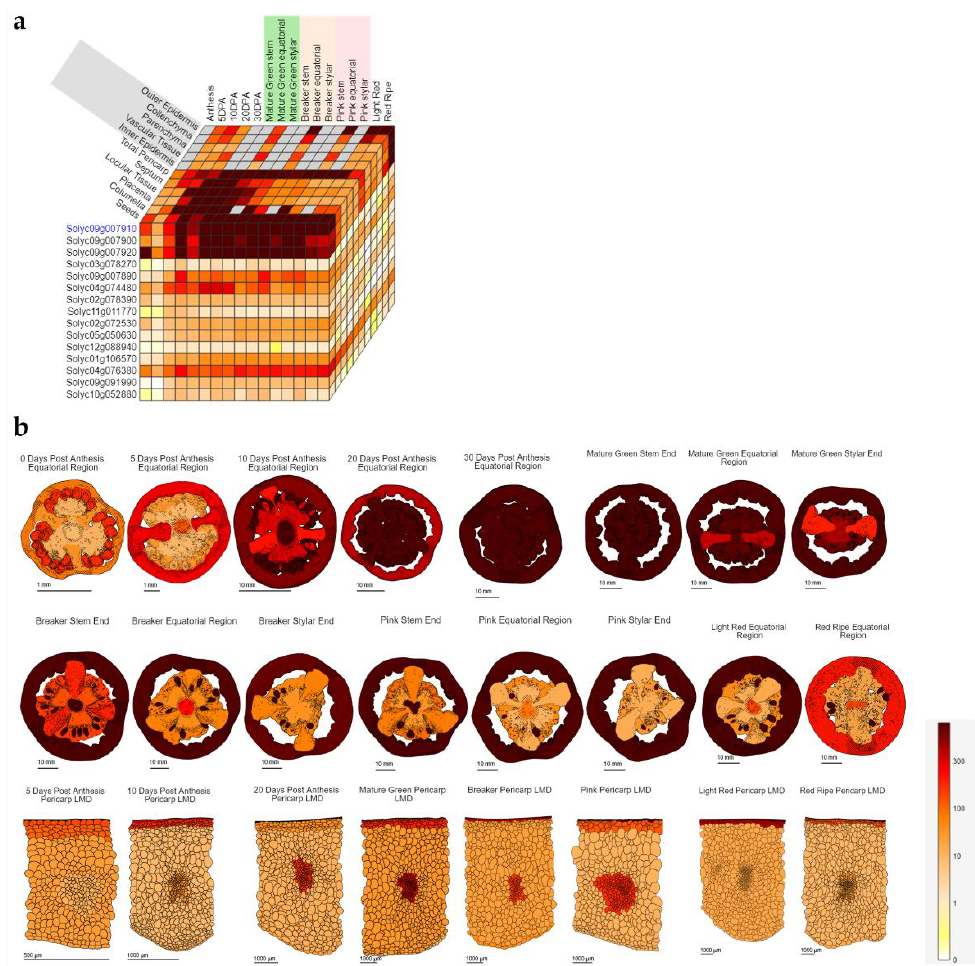
Figure 2. Example of Tomato Expression Atlas visualization using a phenylalanine ammonia lyase ( PAL ) gene (Solyc09g007910) as query. In ( a ) an expression cube with correlated genes; in ( b ) expression images of PAL in the fruit and its tissues at different developmental stages. The bar refers to the expression intensity in RPM (reads per million).